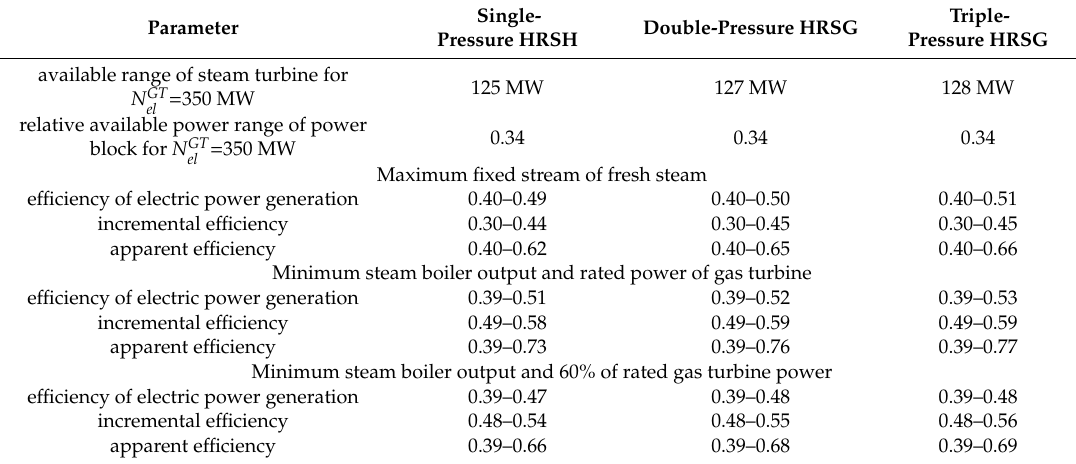
Table 1. Comparison of the most important thermodynamic parameters for various structure of HRSG. Parameter